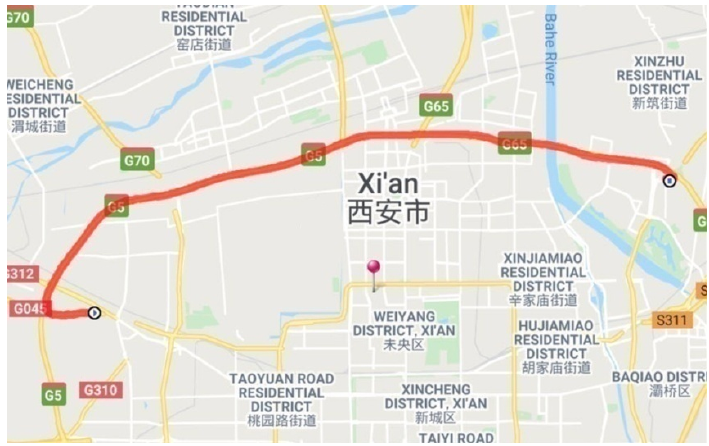
Figure 2. The experiment route map.